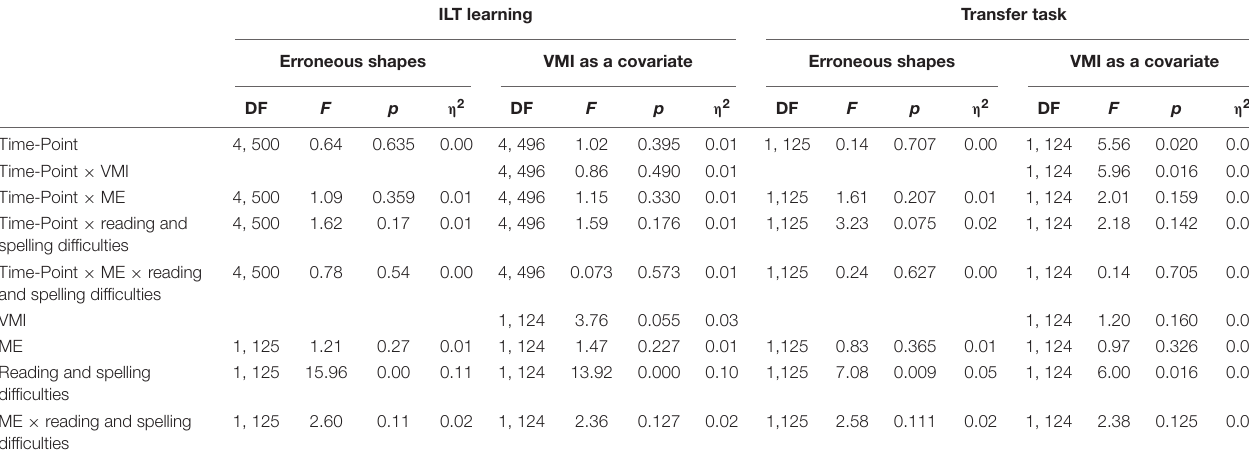
TABLE 3 | Analyses of ILT erroneous shapes.